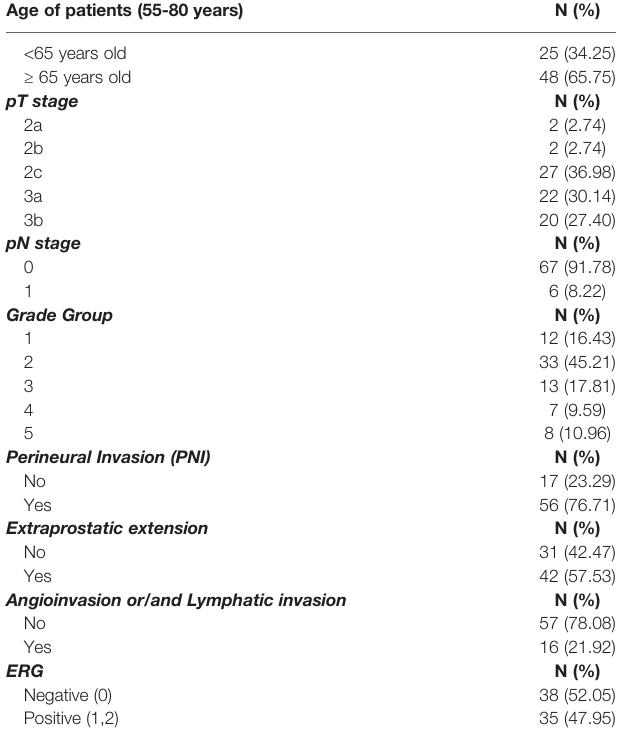
TABLE 1 | The patho-clinical characteristics of the study